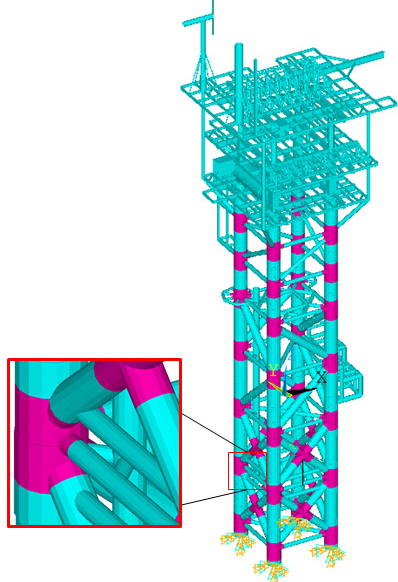
Figure 5. Joints of Gageocho ORS.